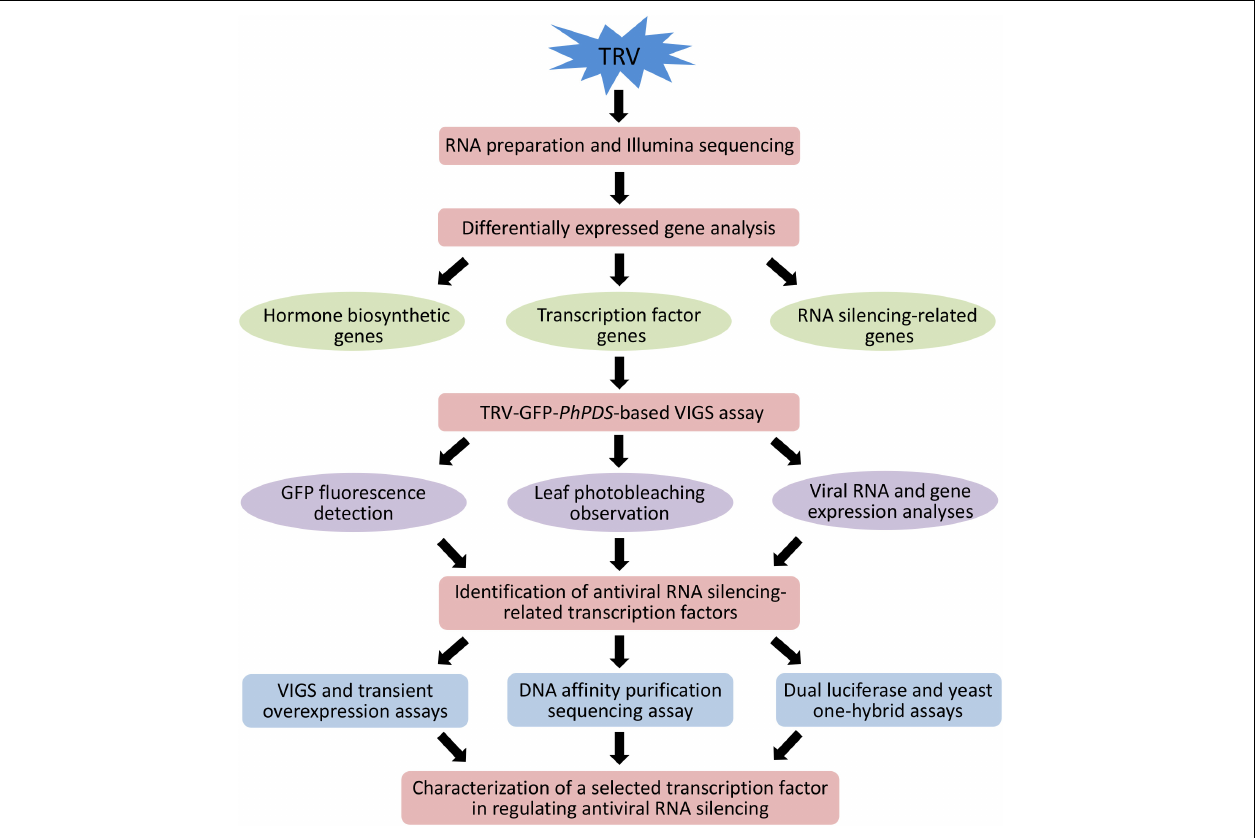
FIGURE 1 | Schematic representation of the experimental strategy to identify important transcription factors involved in antiviral RNA silencing in petunia.